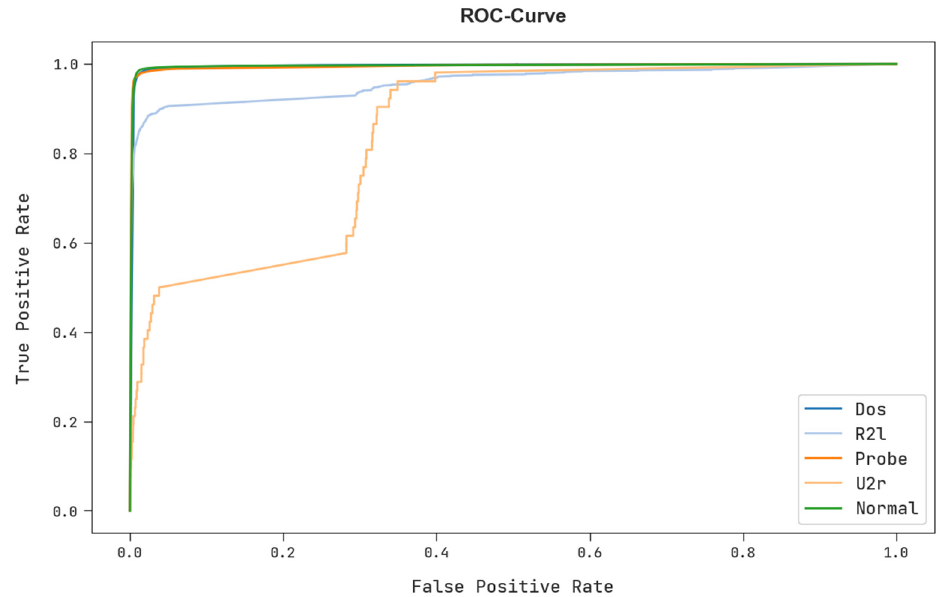
Figure 11. ROC curve analysis of FSHDBN-CID algorithm.